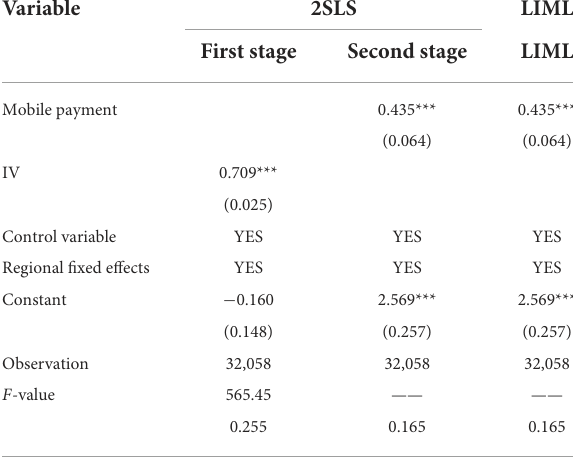
TABLE 3 Results of the impact of mobile payment on health. Variable